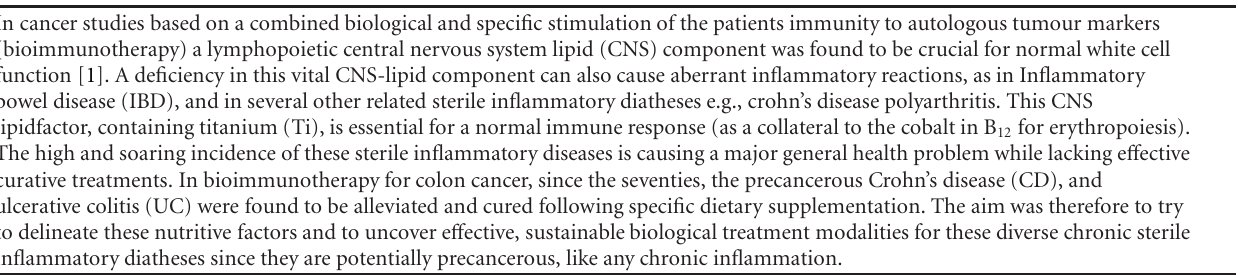
Table 2: Biological dietary treatment for various sterile inflammatory